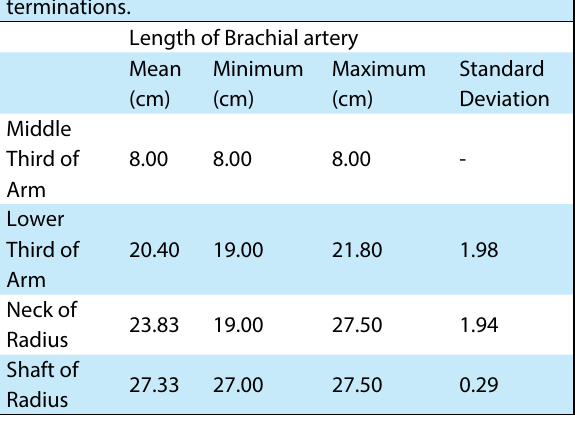
Table 2. Length of brachial artery at different levels of